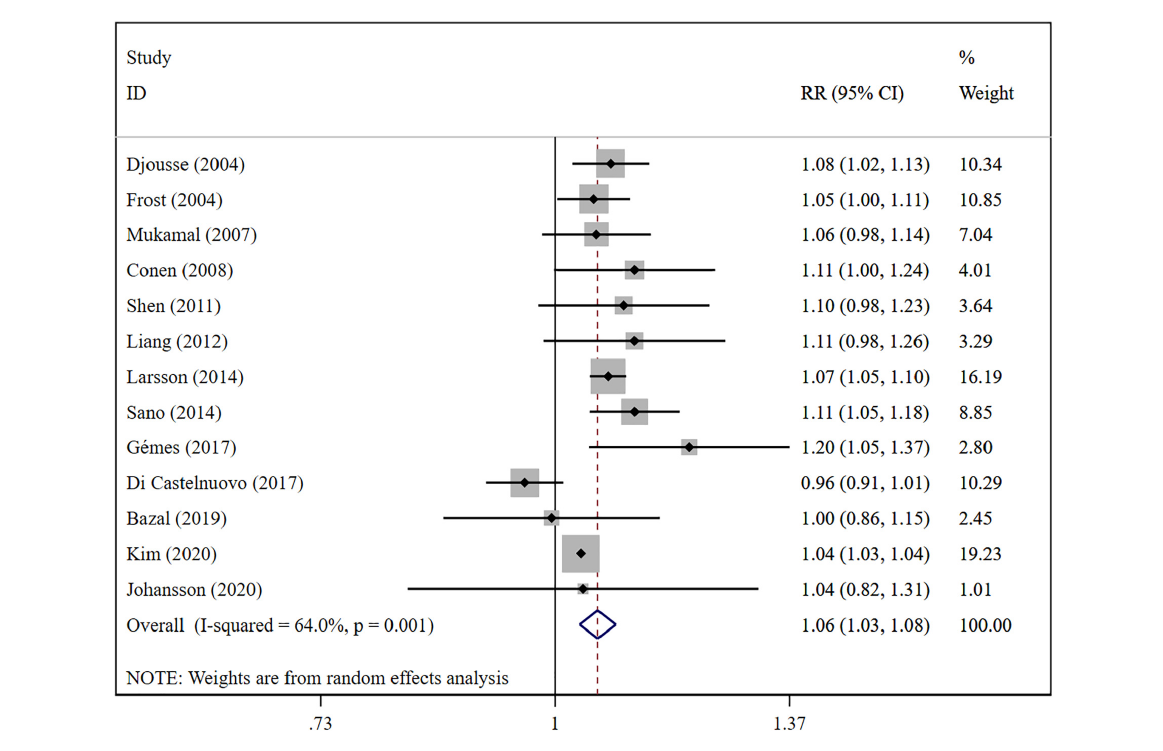
FIGURE2 Forest plot of relative risks of atrial fibrillation per 1 drink/day increment in alcohol consumption.